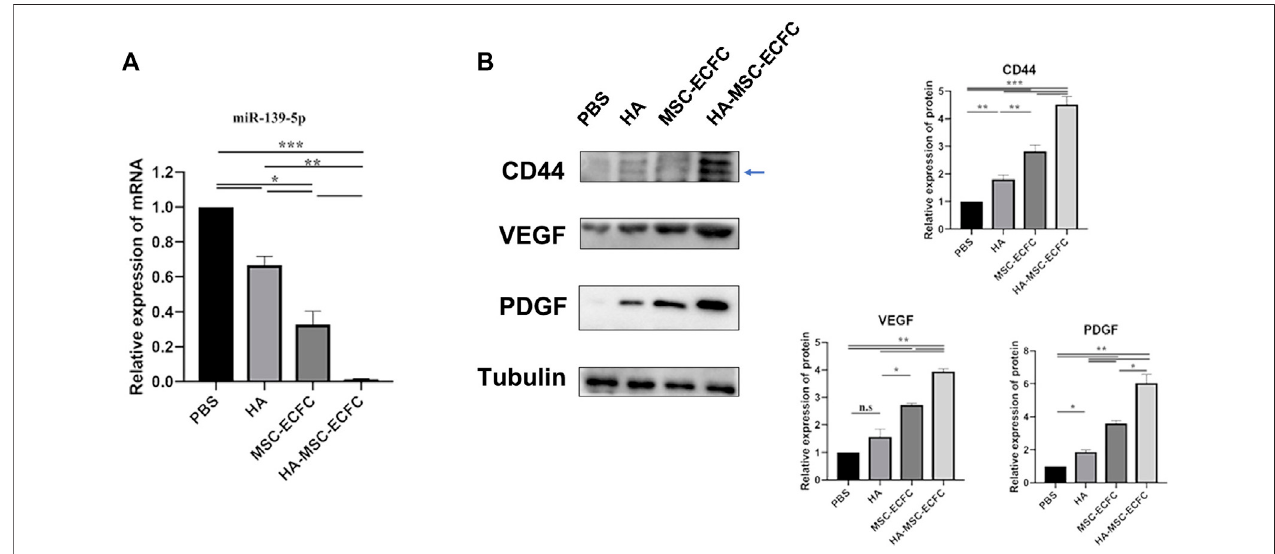
FIGURE4| CD44andmiR-139-5p expressioninischemictissue. (A) .RelativemiR-139-5pexpression and (B) relativeCD44,VEGFandPDGFproteinexpression in the gastrocnemius muscle of the ischemic lower extremity ( n = 3 independent experiments. Error bars: mean ± SD. * p < 0.5, * p < 0.01, * p < 0.001).